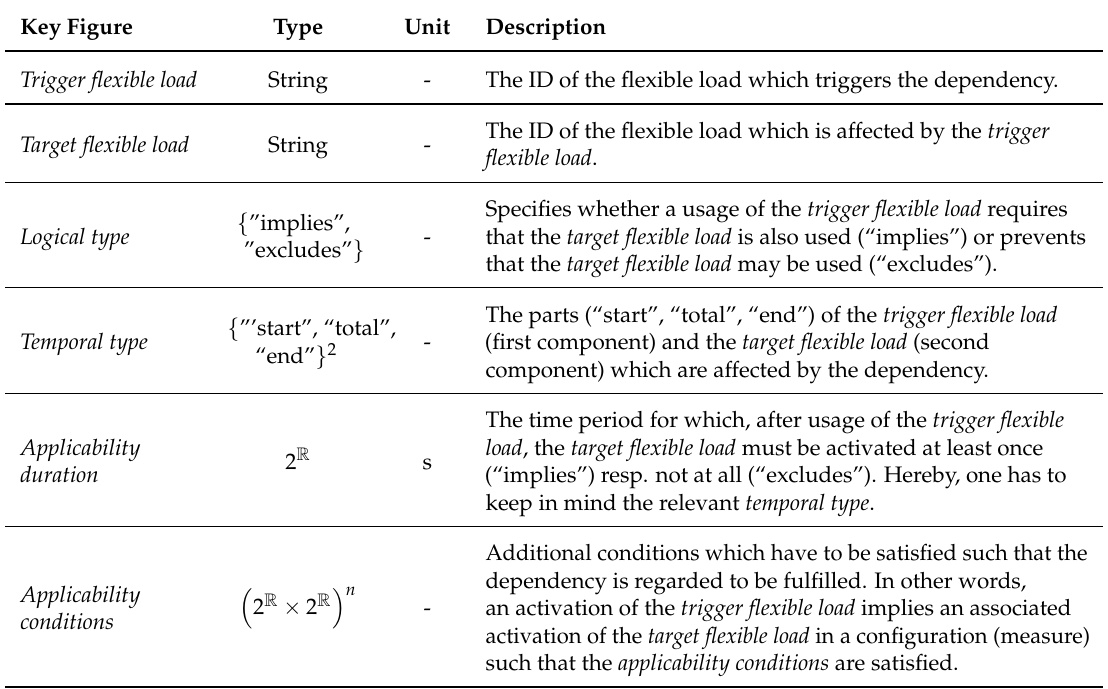
Table 2. Key figures for